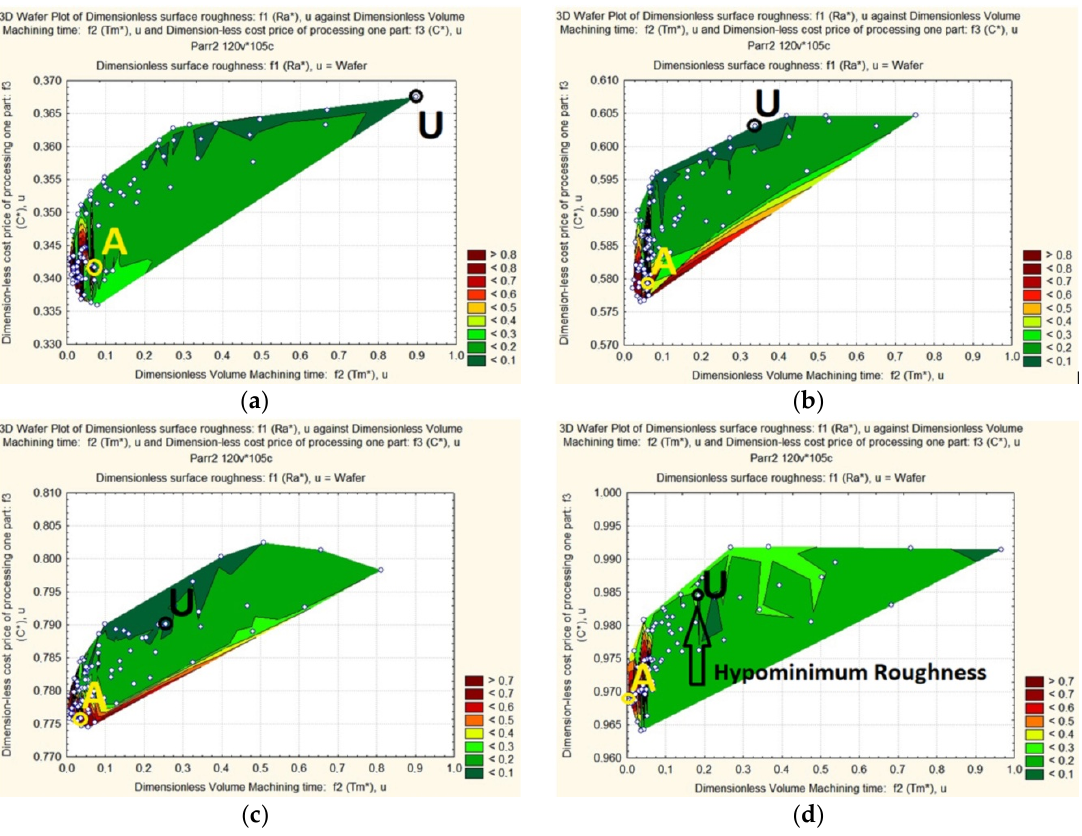
Figure 7. 3D wafer plot of Ra * values for the machined workpiece with respect to changes in C * and T m * values (( a ) method of obtaining an AA6061 alloy workpiece with ET-500 extrusion); ( b ) ECAP-2; ( c ) ECAP-4; ( d ) ECAP-6 hardening of an AA6061 workpiece.